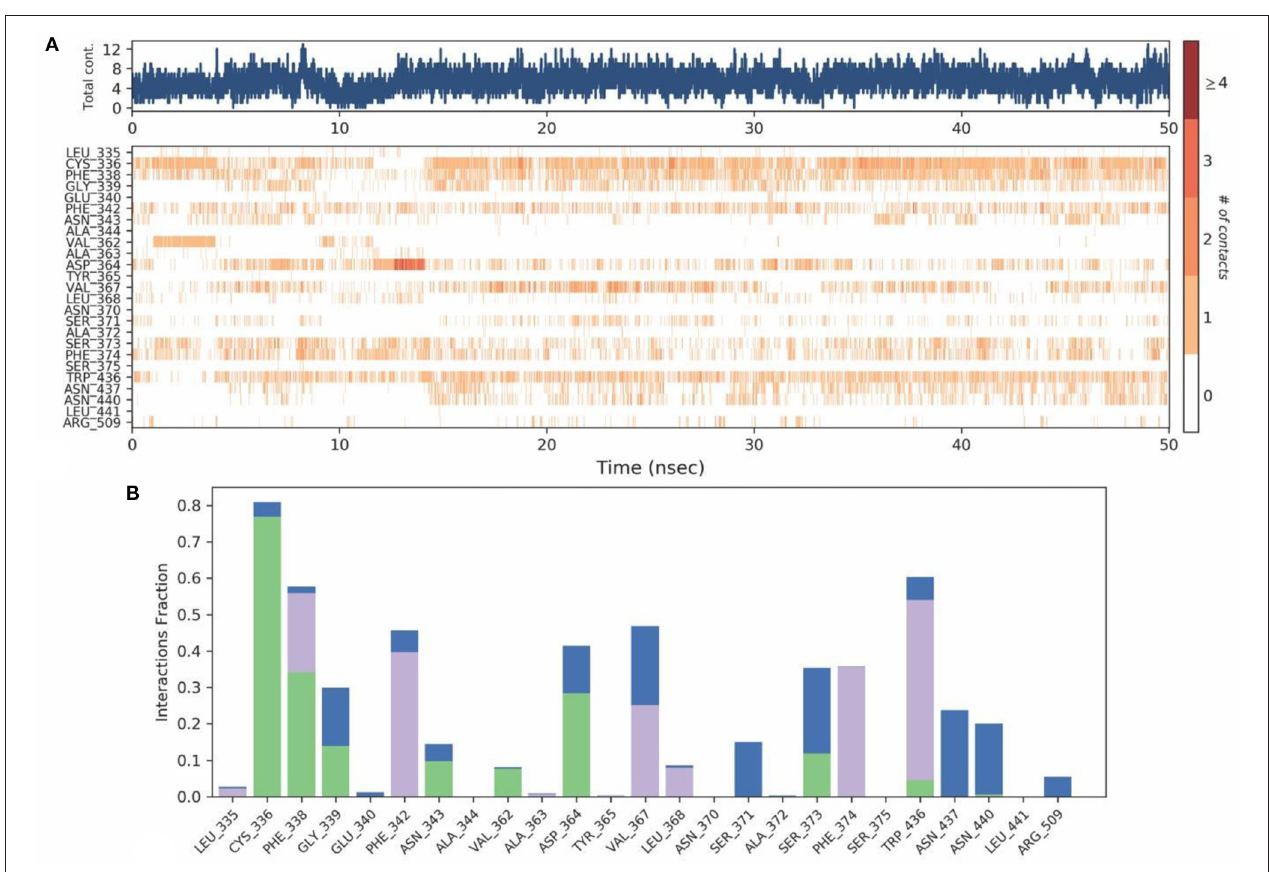
FIGURE 10 | (A) Protein-ligand contact map for 50ns duration for Spike protein and O-Demethyl-demethoxycurcumin complex. (B) Protein -ligand contacts of Spike protein-O-Demethyl-demethoxycurcumin complex simulation (Blue, water bridges; Green, Hbonds; Violet, Hydrophobic).